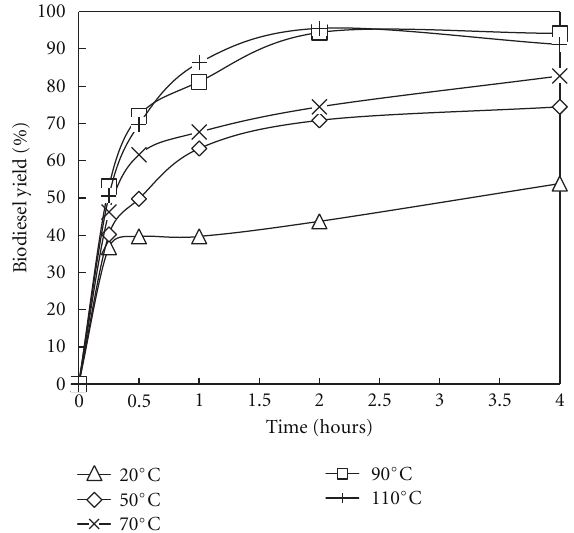
Figure 5: E ff ects of temperature and reaction time on the biodiesel yield by in situ transesterification of C. pyrenoidosa . Reaction condition: 1g algal powder with 6 mL n -hexane, 4mL